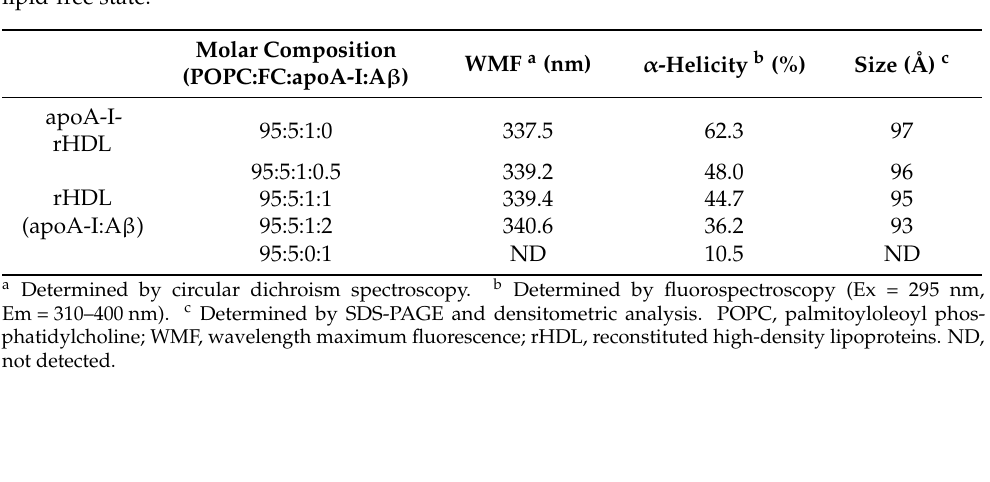
Table 1. Spectroscopic characterization of rHDL containing apoA-I and A β in the lipid-bound and lipid-free